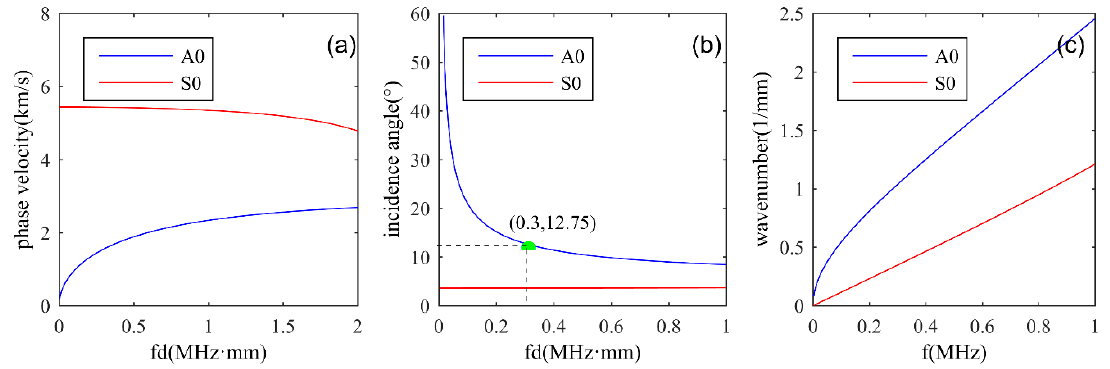
Figure 1. Dispersion curves of an aluminum plate. ( a ) Phase velocity; ( b ) incidence angle; ( c ) wavenumber.